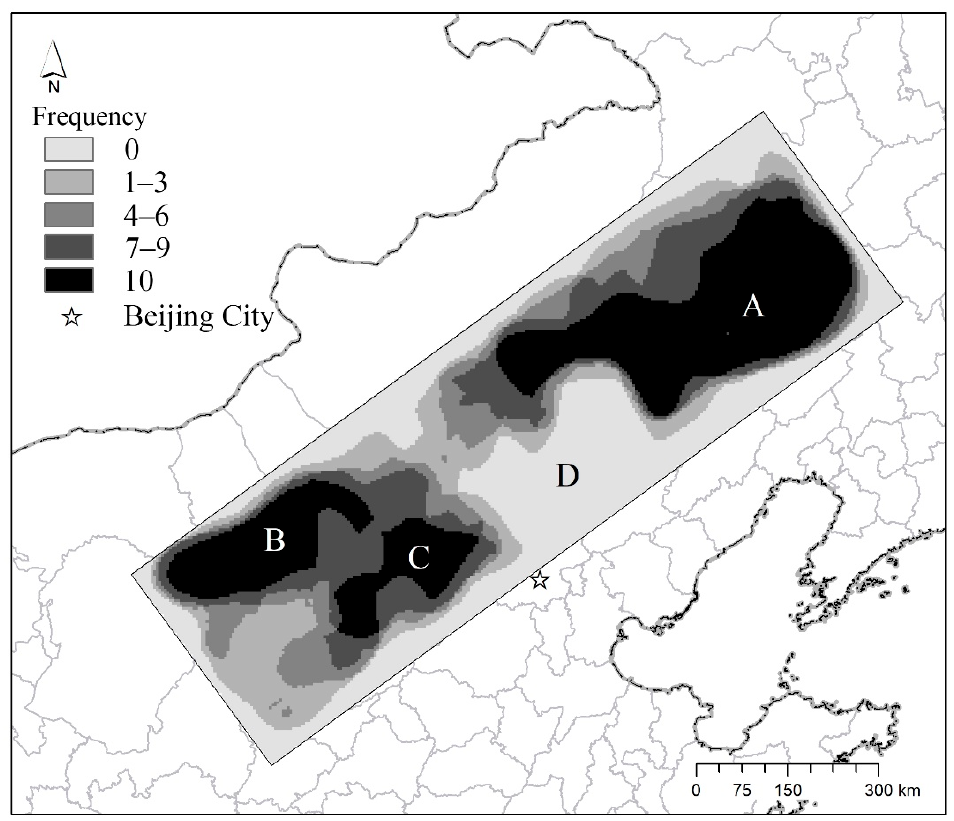
Figure 5. Frequency of identified intense transitional zone during 2006–2015. (Areas A, B and C were always identified as part of the intense transitional zone, while area D was never identified as part of the intense transitional zone).